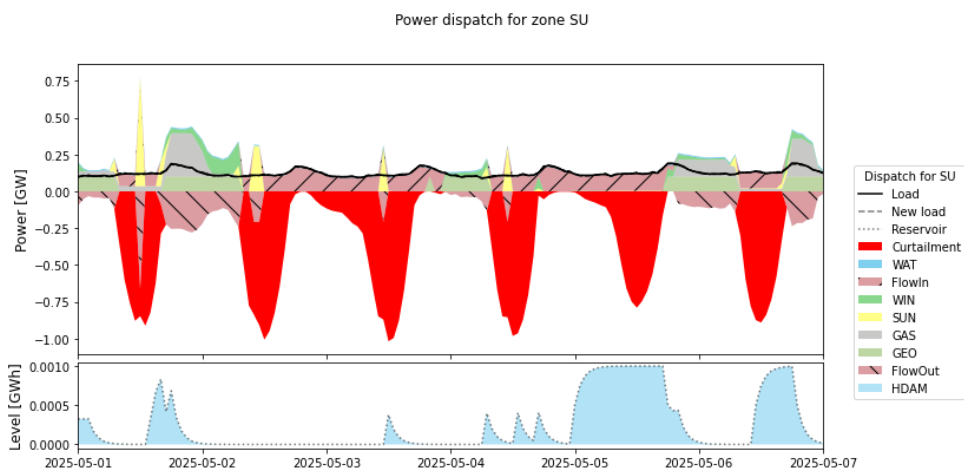
Figure 33. Very-High-Penetration-Scenario 10(NH)—South zone (1–7 May